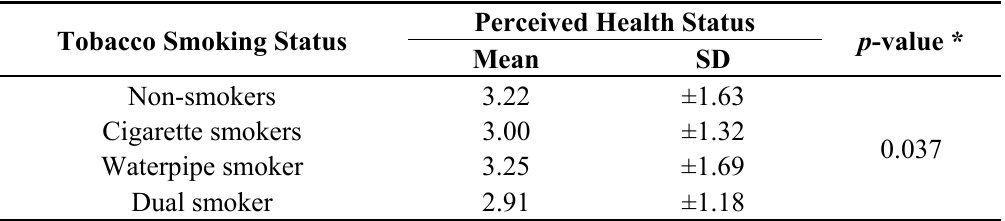
Table 4. Association between participants’ perceived health status and tobacco smoking status. Tobacco Smoking